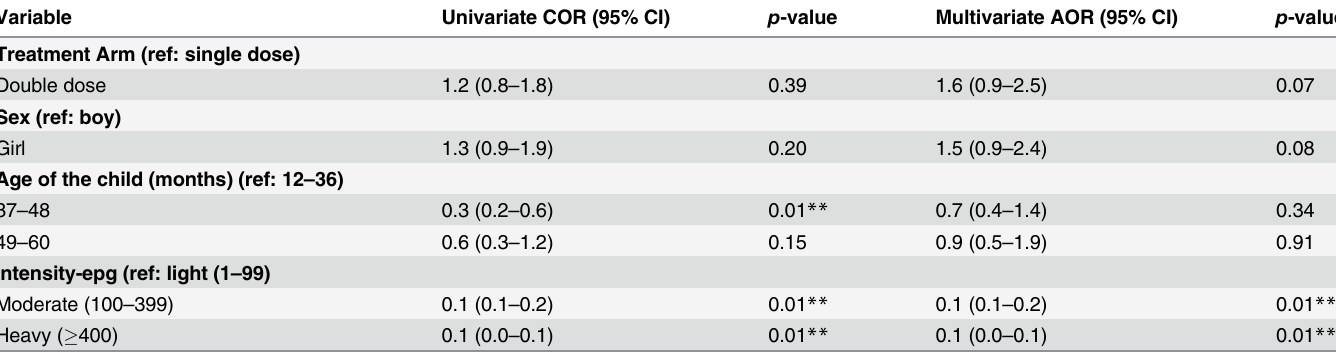
Table 4. Regression analysis of factors associated with cure rate among preschool-age children.